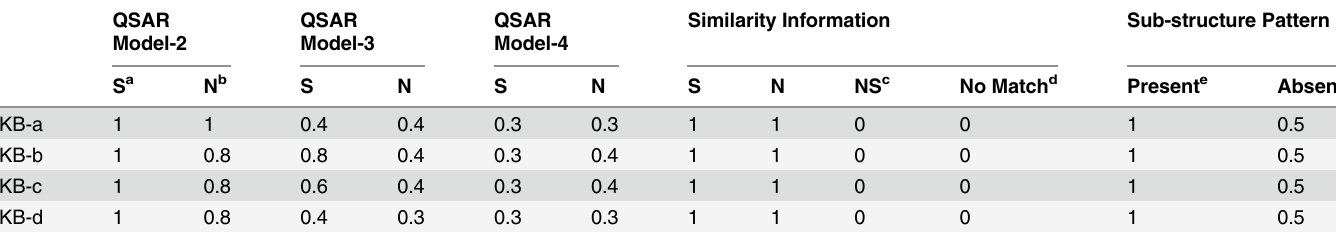
Table 2. Weights used for components of prediction workflows in knowledge-based